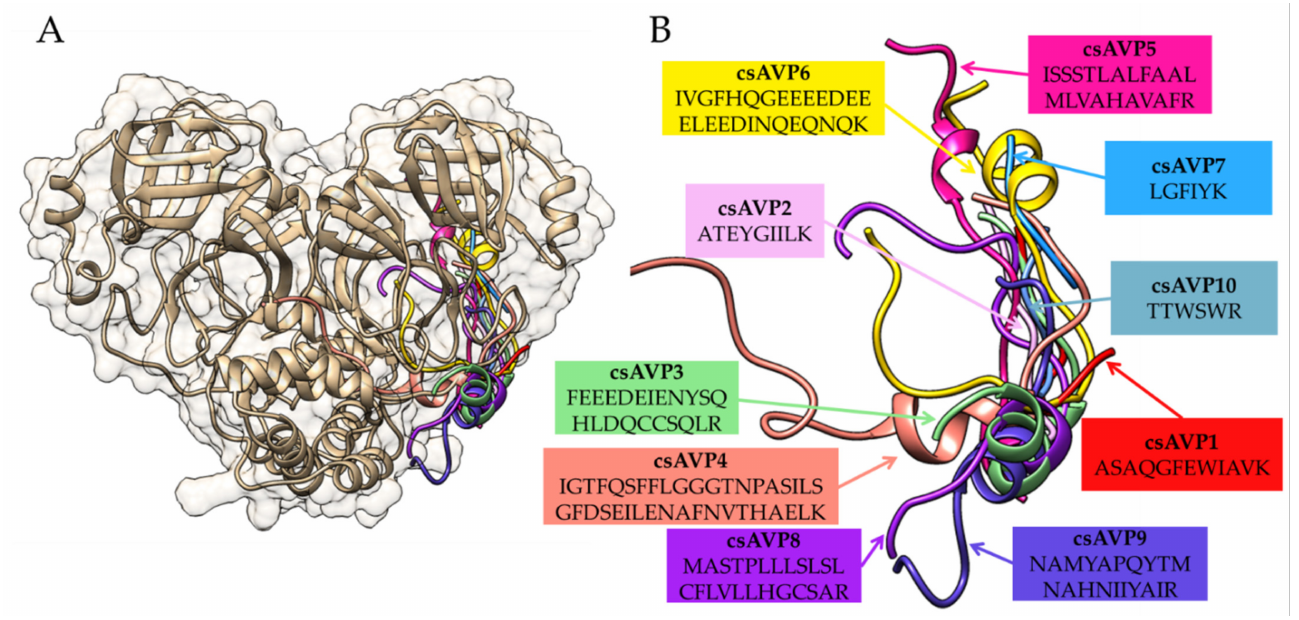
Figure 4. Comparison of molecular docking position of all selected csAVPs (csAVP1 to csAVP10) on the crystal structure of coronavirus 3CL protease in the apo state (PDB ID: 7C2Q) shown with ( A ) and without ( B ) the enzyme structure. Structure of the coronavirus 3CL protease is shaded in gold and the csAVPs are labeled with different